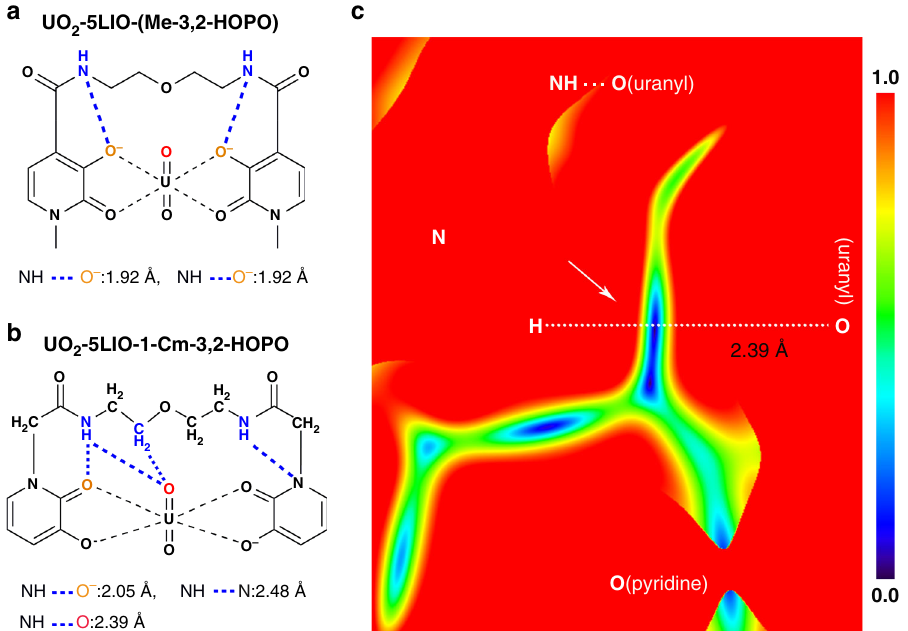
Fig. 4 The intramolecular hydrogen bonds and RDG analysis between 5LIO-(Me-3,2-HOPO)/ 5LIO-1-Cm-3,2-HOPO and U(VI). a Illustration of the intramolecular – NH···O (pyridinone) hydrogen bonds in the UO 2 -5LIO-(Me-3,2-HOPO) complex. b Illustration of the intramolecular – NH···N (pyridine) and – NH···O (pyridinone) hydrogen bonds and intermolecular – NH···O (uranyl) hydrogen bonds in the UO 2 -5LIO-1-Cm-3,2-HOPO complex; c the RDG color- fi lled maps of the N – H – O(uranyl) and sections of b , respectively. The hydrogen bond distances in ( a , b ) are consistent with the structures of Fig. 3b (right) and d ,